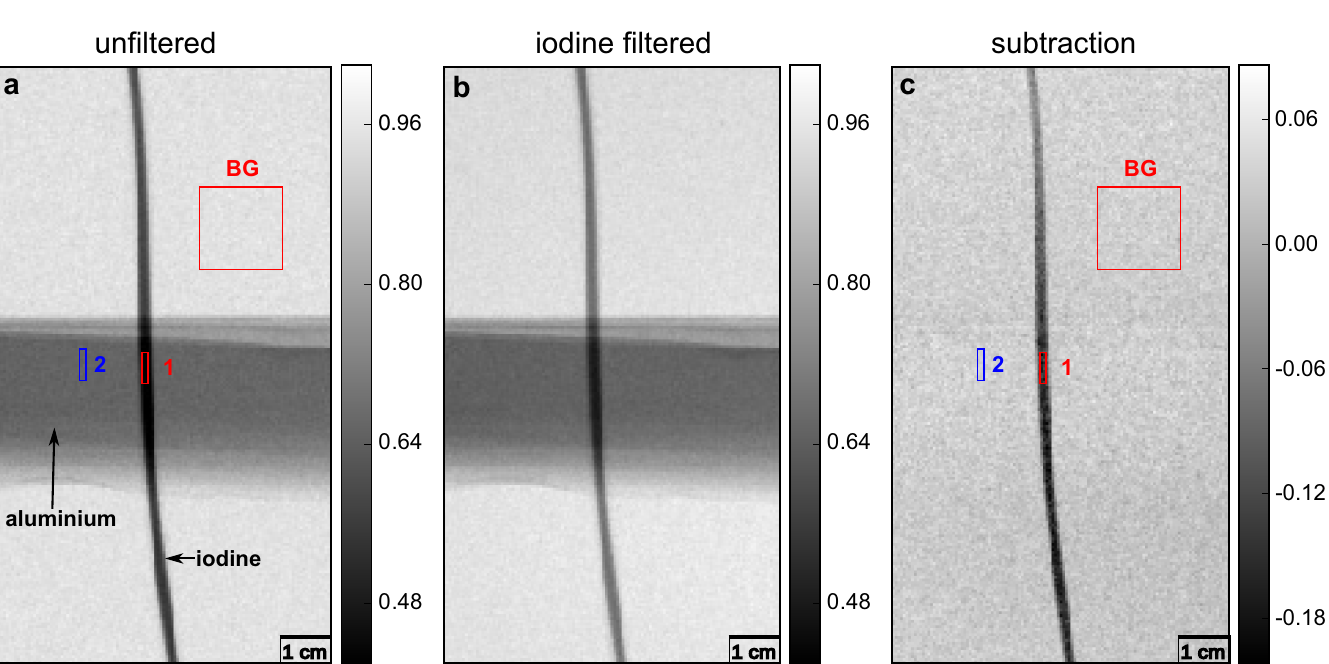
Fig 3. Raw input data (a,b) and processed output image (c) associated with K-edge subtraction (KES) imaging, for a phantom containing aluminum and iodine. (a) Unfiltered reference, (b) iodine- filtered image, and (c) KES image. Both, (a) and (b) , still exhibit aluminum overlaying the tube with iodine contrast agent. KES- imaging (for details see text) provides the aluminum-free pure iodine contrast image (c) . The ROIs chosen for the calculation of the CNRs of iodine (1) and aluminum (2) are shown in image (a) and (c) . The gray scales for the unfiltered and filtered images display the relative intensity / transmission of the X-ray beam, while the gray values in the KES image c show the negative differences in the